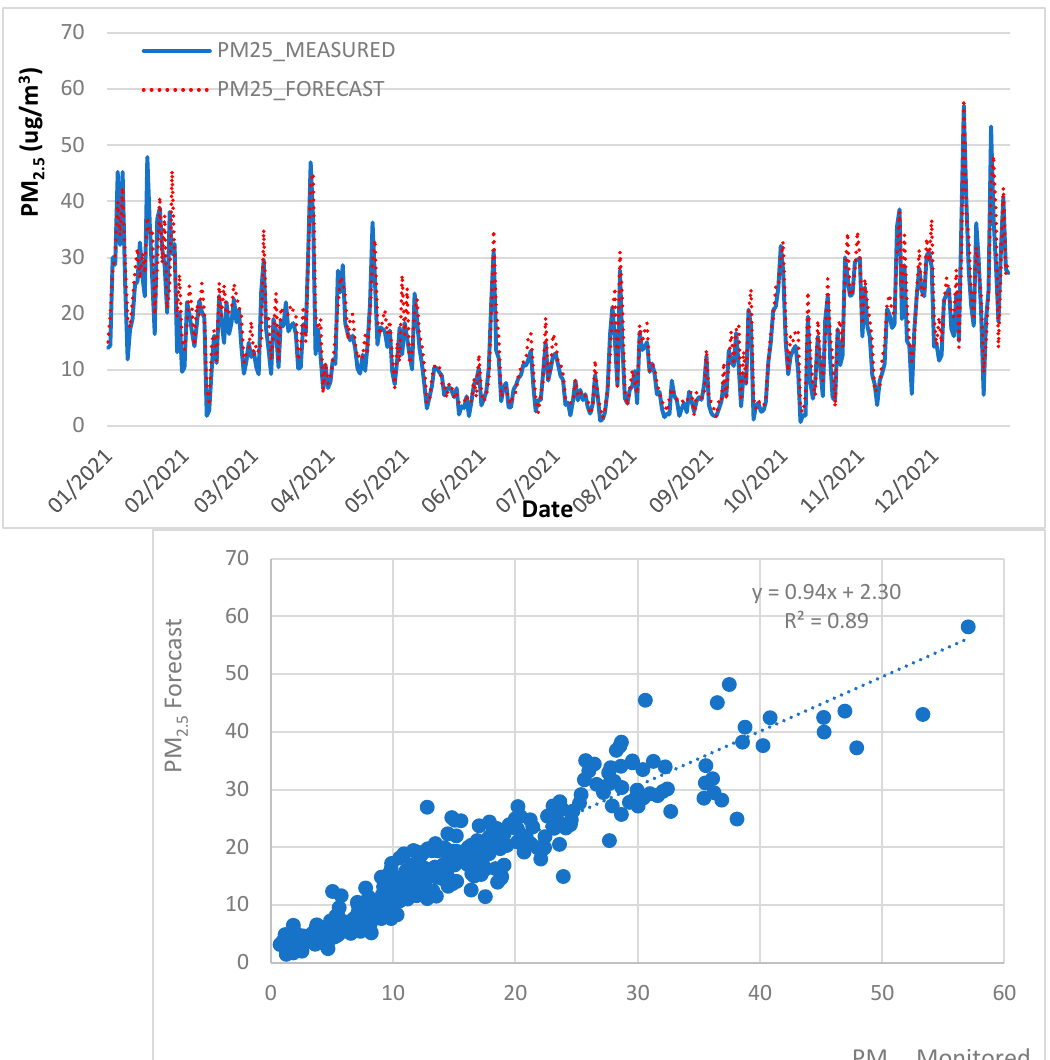
Figure 7. Observed and predicted PM 2.5 concentrations using RF in 2021.